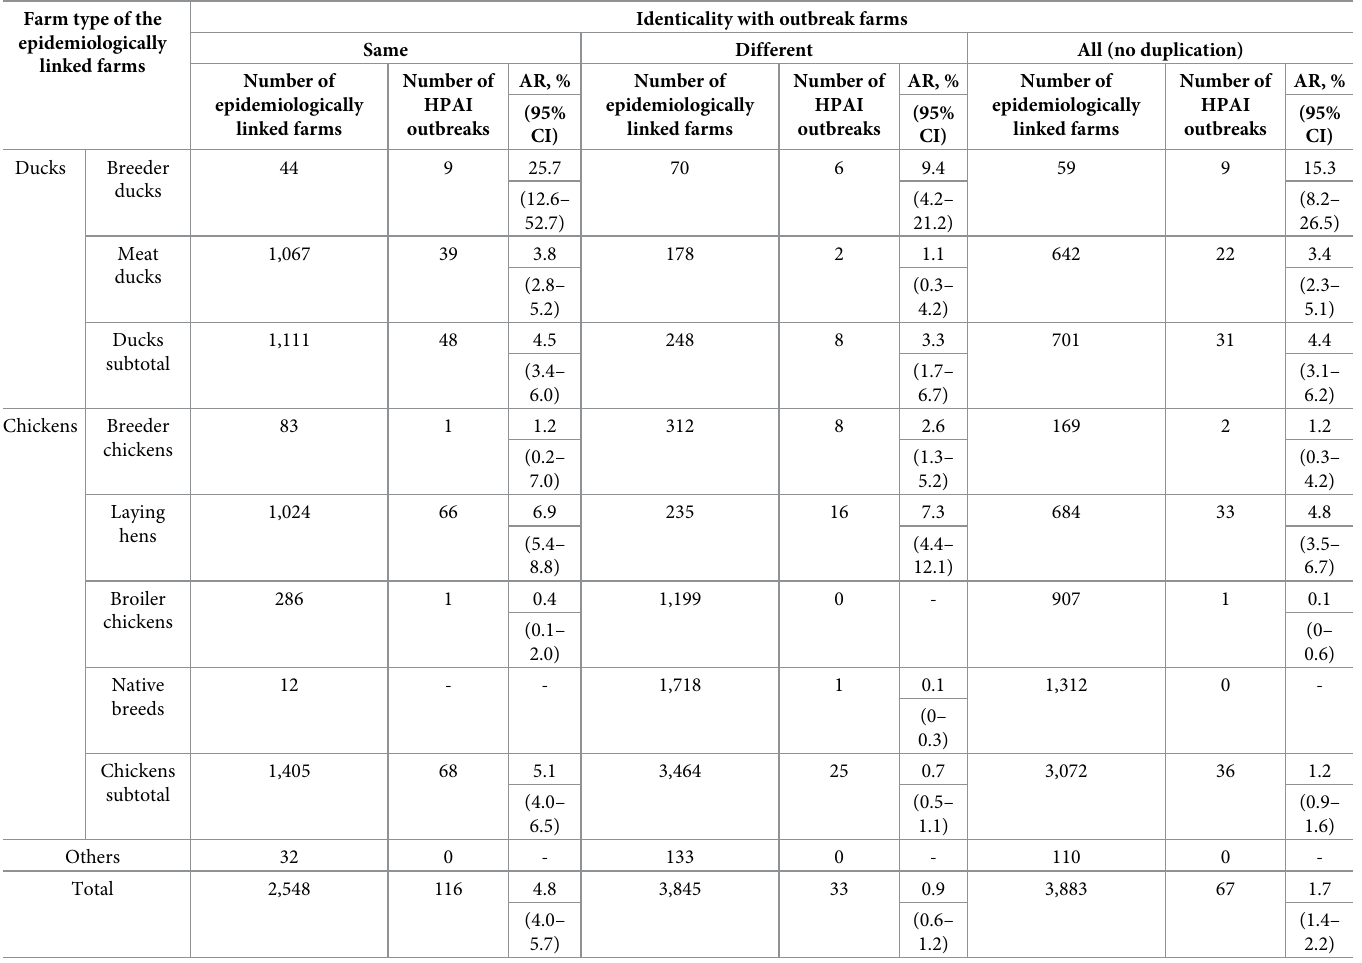
Table 3. Farm type identicality between HPAI outbreak farms and epidemiologically linked farm, and the Attack Rates (AR) on epidemiologically linked